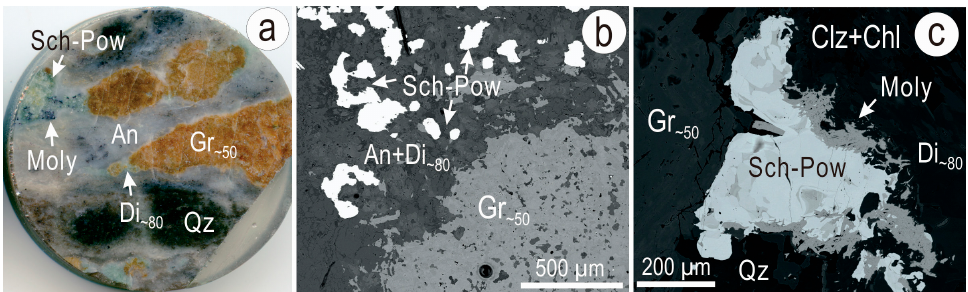
Figure 2. Reflected light photograph of 1”-diameter polished section ( a ) and back-scatter electron (BSE) images ( b , c ) showing petrographic aspects of the skarnoid containing the analysed scheelite-powellite grains. ( a ) Grossular (Gr ~50 ) lenses in a groundmass of anorthite (An) and diopside (Di ~80 ). Quartz (Qz)-chlorite (Chl) rich-areas are relicts from the tuff protolith. ( b ) Edge of stringer zone with scheelite-powellite (Sch-Pow) at the boundary to one of the grossular garnet lenses. ( c ) Aggregate of Sch-Pow with molybdenite (Moly) along the margins. The groundmass includes secondary clinozoisite (Clz) and Chl.